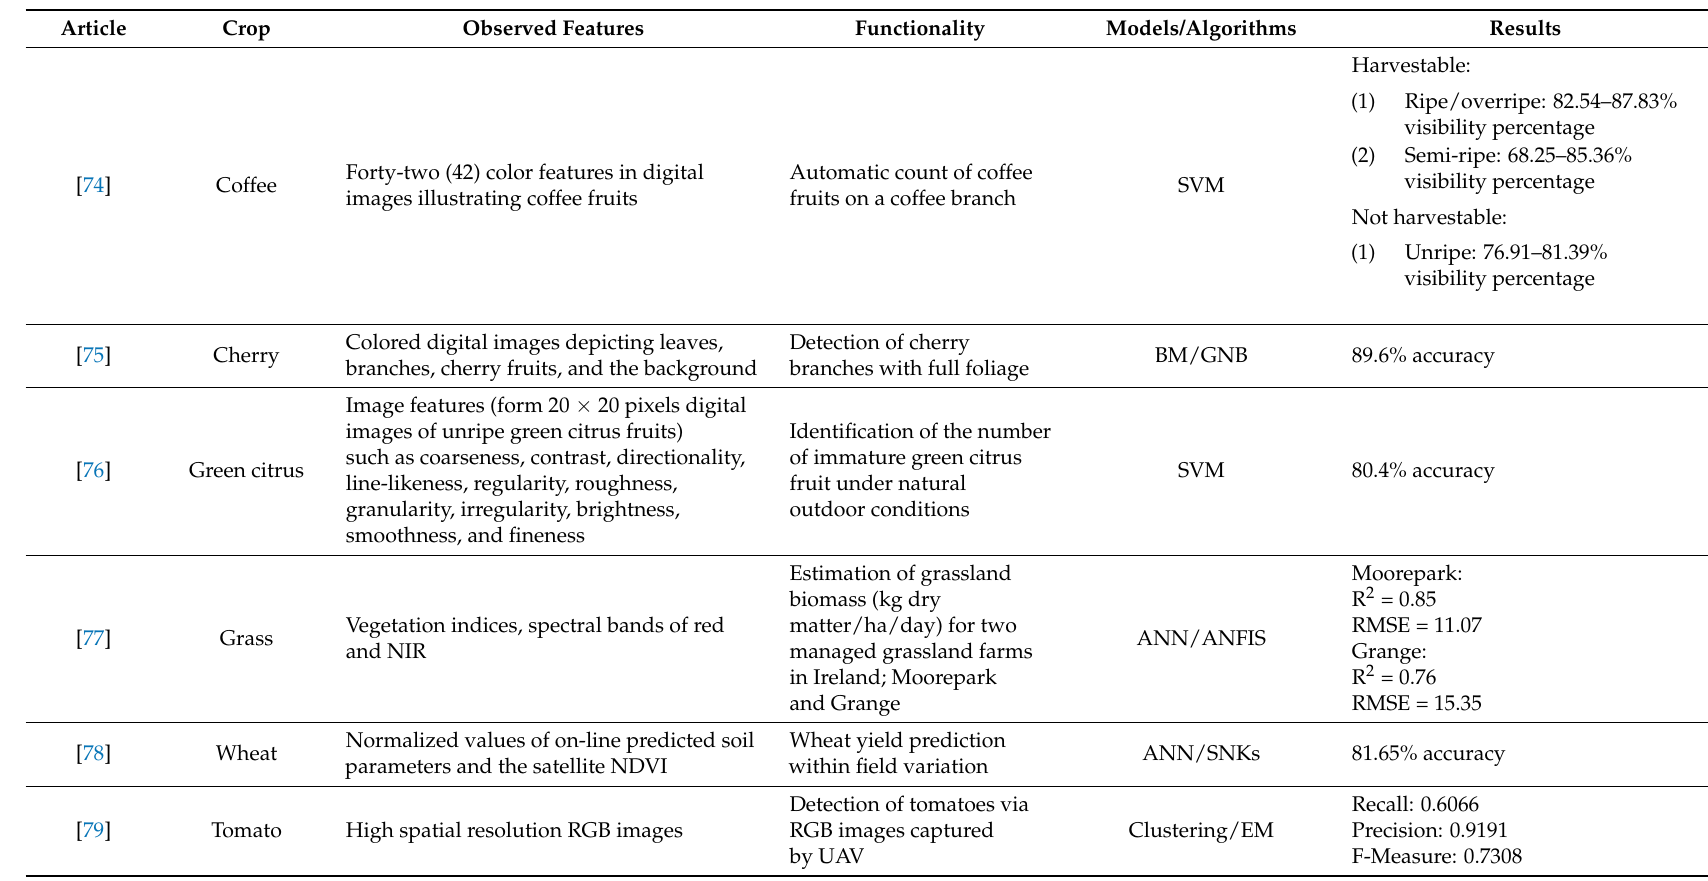
Table 5. Crop: yield prediction